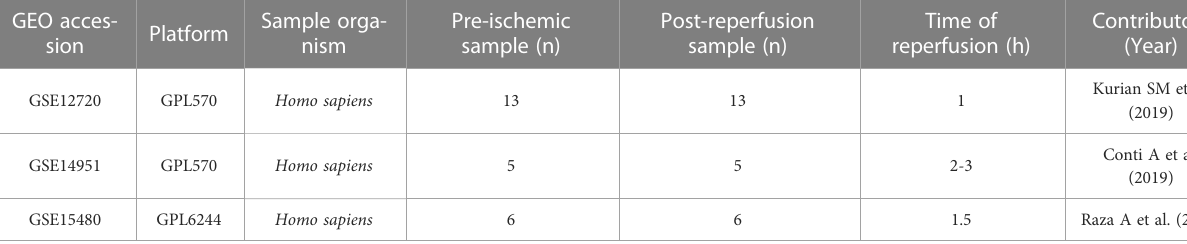
TABLE 1 Details of a transcriptomic dataset of liver transplant